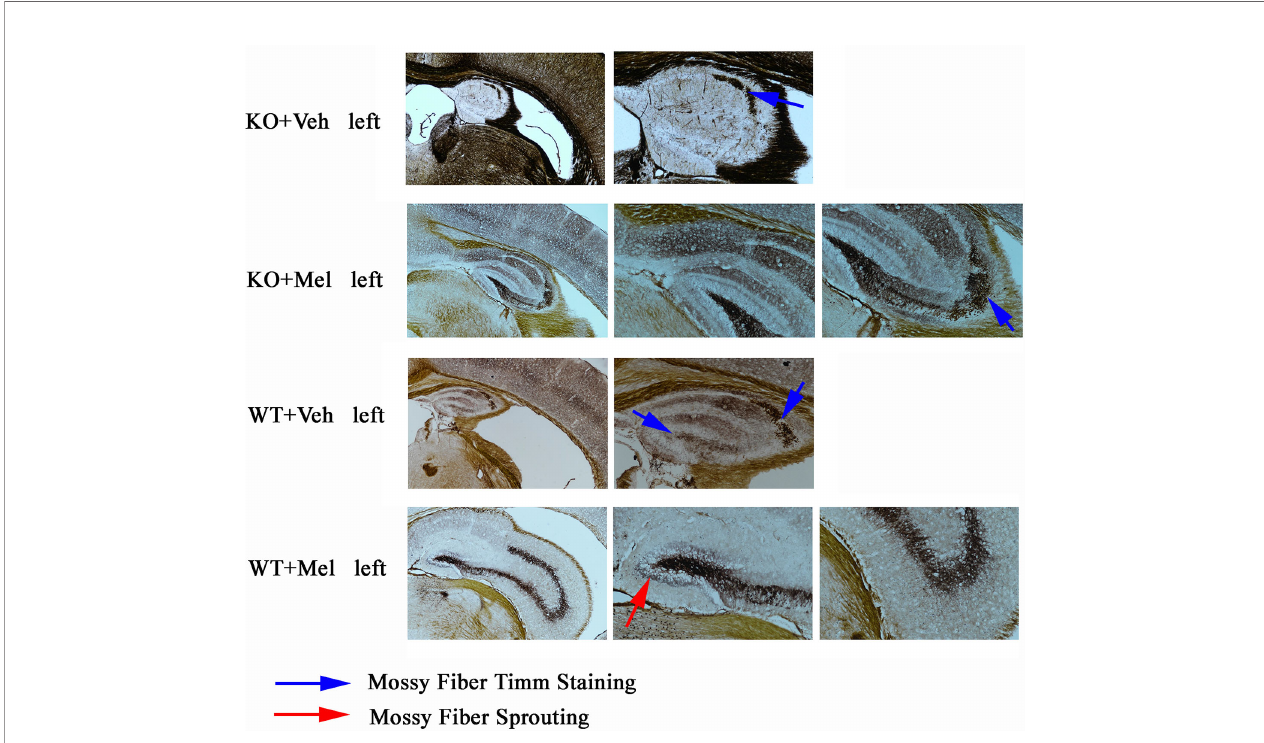
FIGURE 7 | Timm staining results of left brain. Blue arrow means moss fi ber staining. Red arrow means moss fi re sprouting. Magni fi cation is 40 times for fi rst column (four pictures) and the others are 100